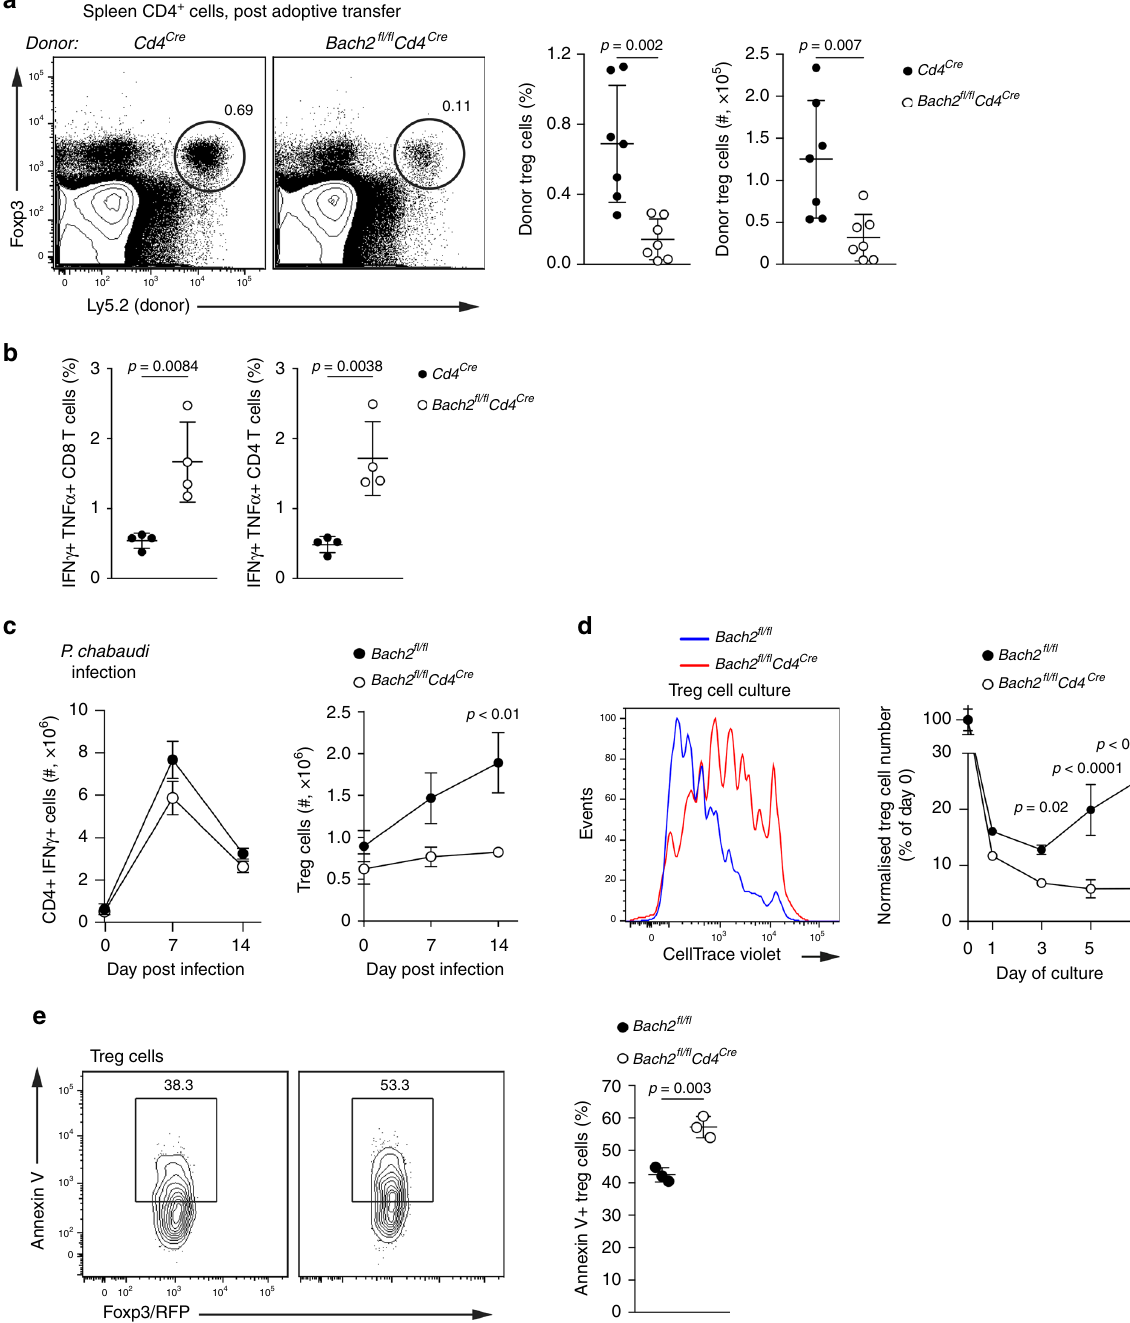
Fig. 2 Bach2 is required for the survival and proliferation of Treg cells. a , b Treg cells sorted from Cd4 Cre or Bach2 fl / fl Cd4 Cre mice were adoptively transferred into congenically marked Foxp3 diphtheria toxin receptor transgenic mice depleted of endogenous Treg cells by injection of diphtheria toxin. a Representative fl ow cytometry plots indicate the frequency of donor Treg cells among the CD4 + compartment (left), and quanti fi cation of Treg cell numbers (right), 7 days following adoptive transfer. b Frequency of IFN- γ /TNF co-expressing cells among the splenic CD8 and conventional CD4 T cell populations, as measured by fl ow cytometry. c Splenic Th1 (left) and Treg (right) cell numbers from Bach2 fl / fl Cd4 Cre and Bach2 fl / fl control mice following infection with Plasmodium chabaudi . d Flow cytometry histograms of CellTrace Violet dilution at day 5 of culture (left) and normalized total cell numbers of Treg cells from Bach2 fl / fl Cd4 Cre and Bach2 fl / fl control mice at the indicated culture time points (right). e Cell-surface binding of Annexin V by Treg cells isolated from Bach2 fl / fl and Bach2 fl / fl Cd4 Cre mice following 24 h of culture. Flow cytometry plots and data from ( b – d ) are representative, data in a are pooled from two independent experiments with at least four mice per genotype. Signi fi cance tested using two-way ANOVA with the Š idák correction for multiple comparisons ( d ). Otherwise, statistical signi fi cance was tested using the unpaired Student ’ s t- test. Error bars denote mean ±S.D. a , b , d , e or ±S.E.M. c Source data are provided as a Source Data fi